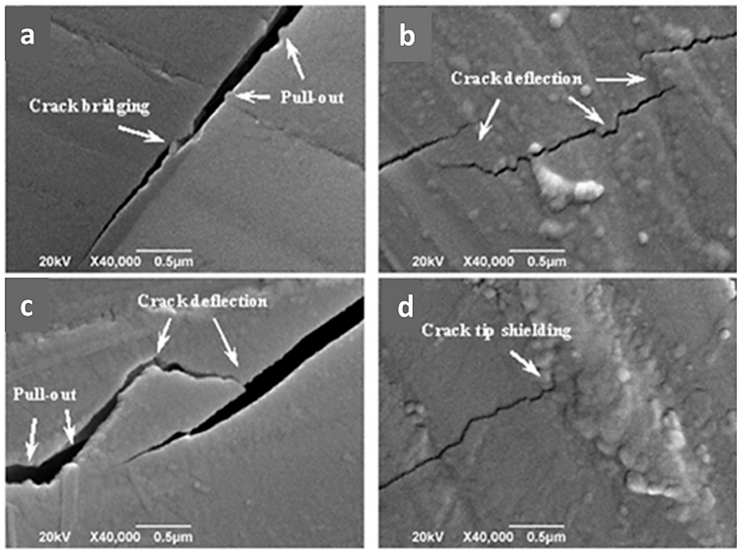
Figure 2. Inhibition of crack propagation by graphene in bioactive glass scaffold by different mechanisms: ( a – c ) crack deflection, crack bridging and graphene pull-out; ( d ) termination of crack growth at the crack tip [73].